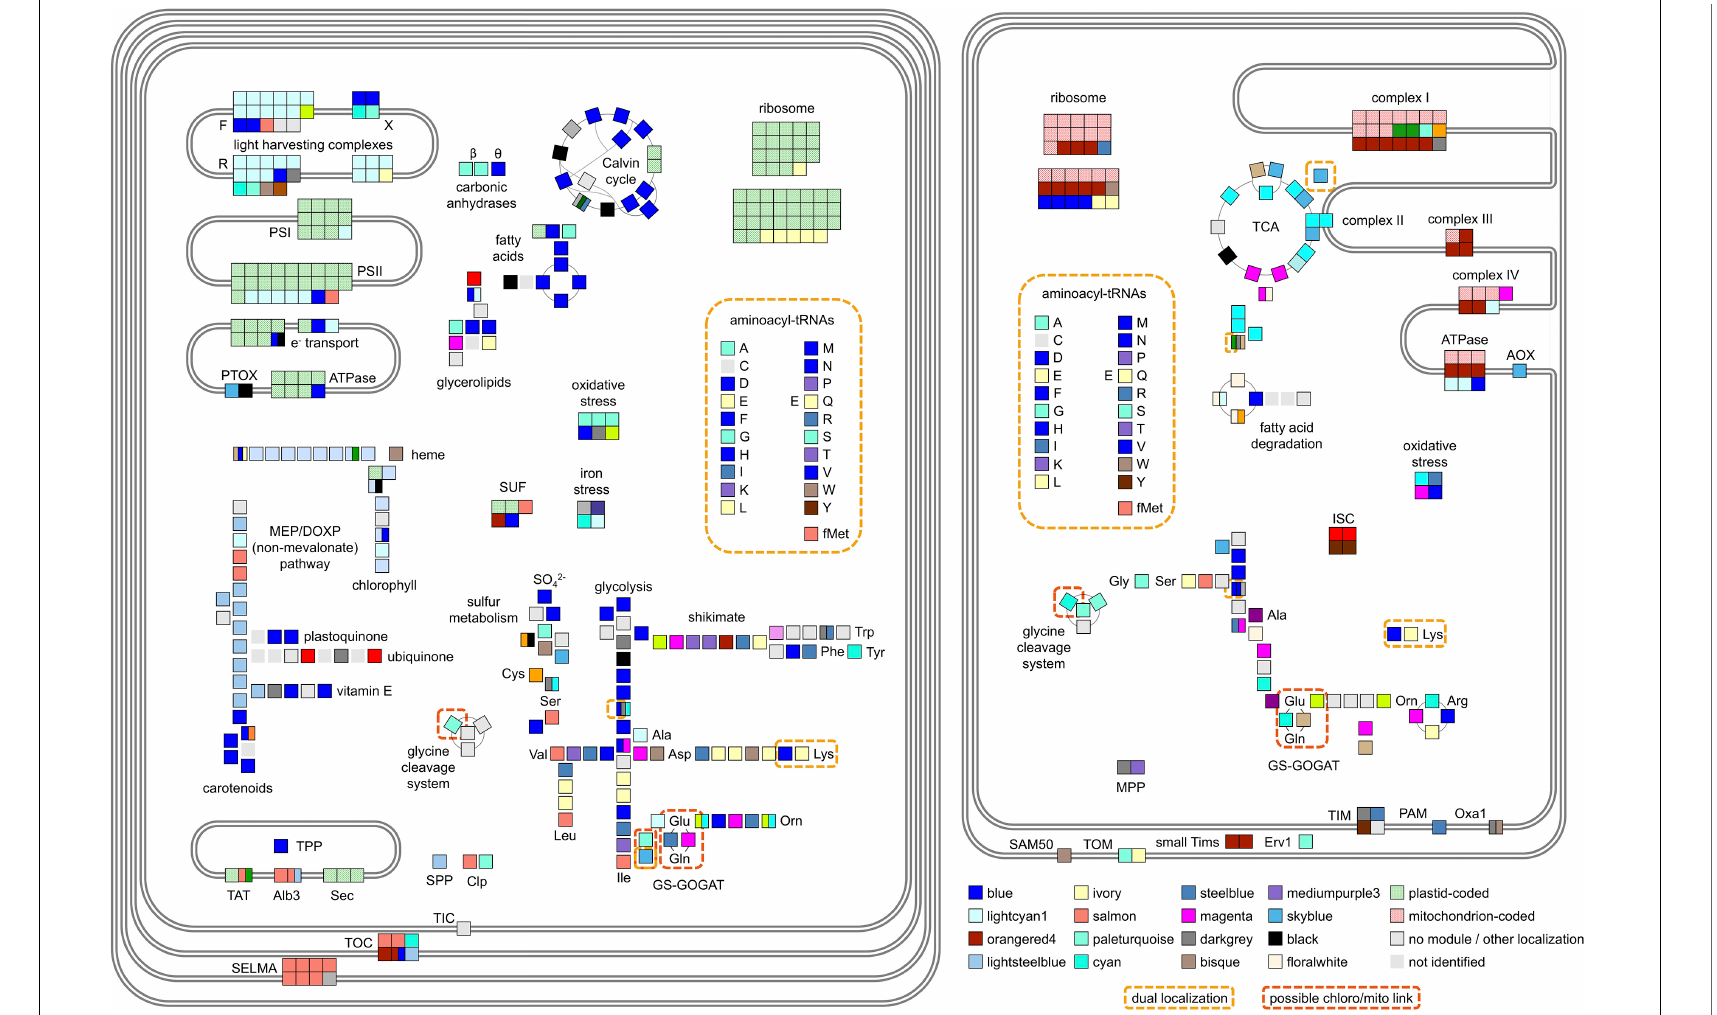
FIGURE 4 | Main metabolic pathways and functional complexes of P. tricornutum plastid (left) and mitochondrion (right) and their composition in regard to PhaeoNet merged modules. Each square represents a gene encoding a protein identified either from N-terminal targeting predictions to function in the chloroplast or mitochondrion. Clusters of adjacent squares pertain to genes encoding different components of a specific multi-unit enzyme or complex; and split squares pertain to genes encoding functional homologs of one specific protein. The assigned merged modules are indicated as their respective colors, with the 16 most abundant merged modules shown in the legend. Additionally, proteins coded in organellar genomes (Oudot-Le Secq et al., 2007; Oudot-Le Secq and Green, 2011; Yu et al., 2018) are shown as dotted green or red; proteins for which chloroplast- or mitochondria-targeted isoforms or merged modules could not be assigned are shown as light gray; and enzymatic steps not identified in the genome are shown as light gray squares without borders. Dual-localized proteins (Gile et al., 2015; Dorrell et al., 2017) are marked by checkered yellow boxes; while orange boxes highlight potential connection points between the two organelles. Abbreviations are as follows: CAs, carbonic anhydrases; MEP/DOXP, mevalonate and non-mevalonate pathways for isoprenoid biosynthesis; SUF, iron-sulfur complex assembly; MPP,/TPP/SPP, mitochondrial, thylakoid and stromal processing peptidases; TAT, twin-arginine-dependent thylakoid protein import pathways; AOX/PTOX, mitochondrial and chloroplast alternative oxidases; TCA, Citric Acid cycle; Orn, ornithine; GCS, glycine shuttle; GS-GOGAT, glutamine synthetase/glutamate synthase shuttle. Detailed enzyme distributions for each pathway are shown in Supplementary Figure 6